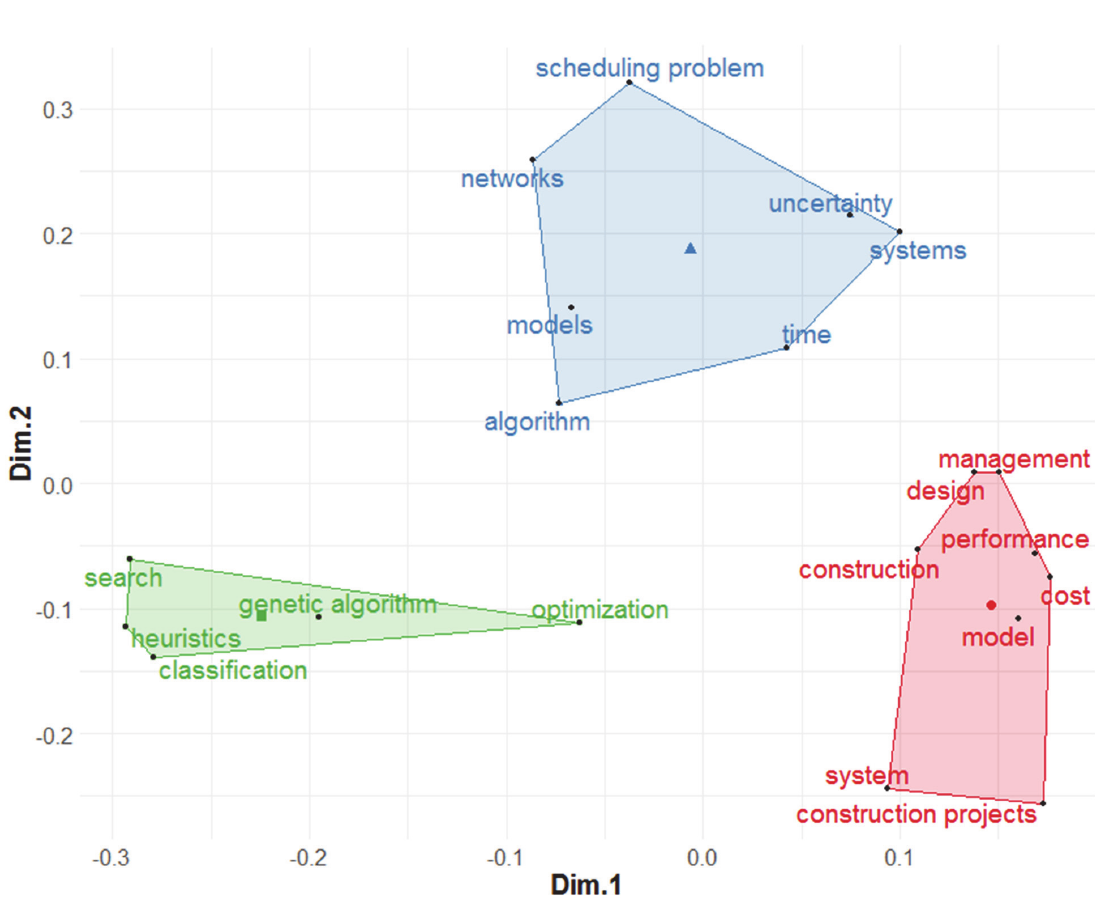
Fig. 5. Conceptual structure